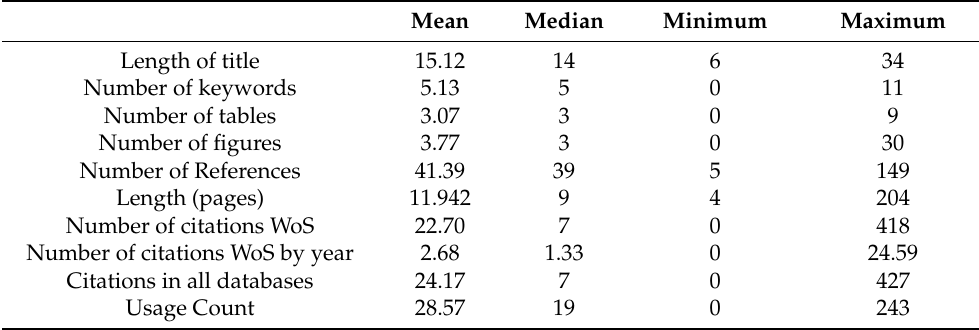
Table 1. Length of title, keywords, and number of tables, figures, and pages of studies about outdoor